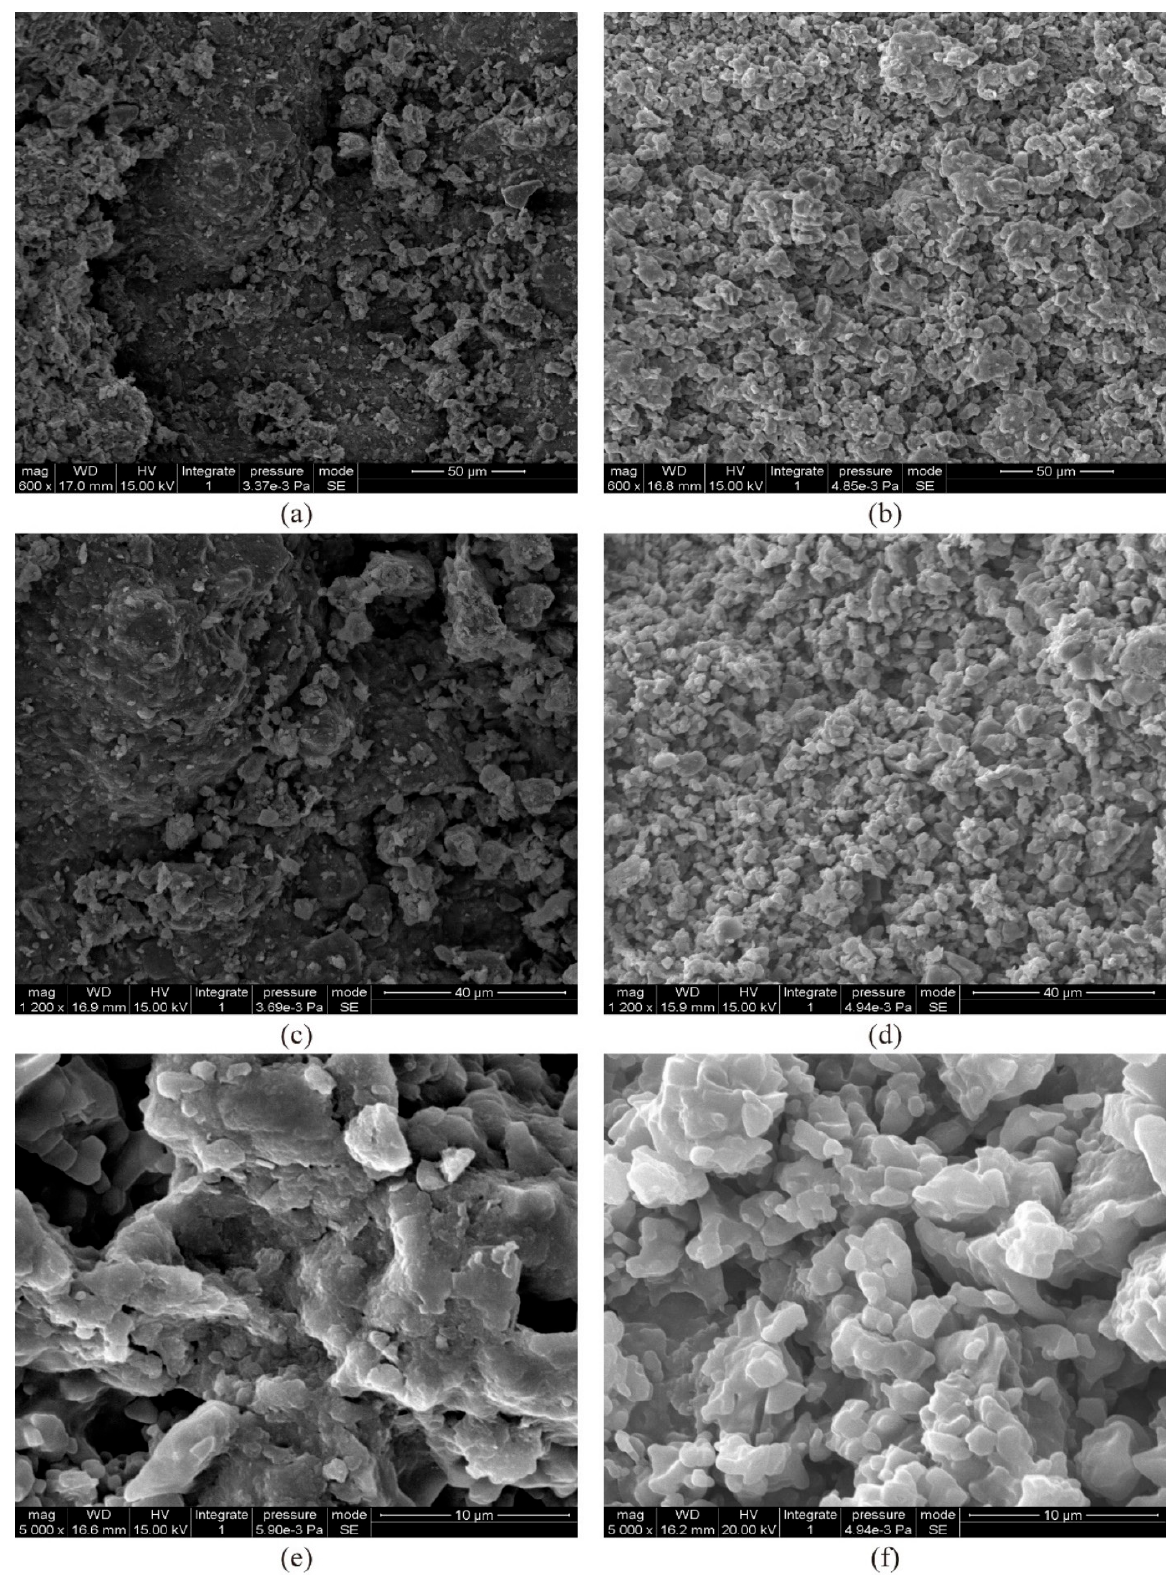
Figure 12. SEM micrographs of: ( a ) natural sample at 600 times magnification; ( b ) treated sample with 27.5% CaCl 2 and 21.2% Na 2 CO 3 at 600 times magnification after 7 days; ( c ) natural sample at 1200 times magnification; and ( d ) treated sample with 27.5% CaCl 2 and 21.2% Na 2 CO 3 at 1200 magnification after 7 days; ( e ) natural sample at 5000 times magnification; and ( f ) treated sample with 27.5% CaCl 2 and 21.2% Na 2 CO 3 at 5000 times magnification after 7 days.